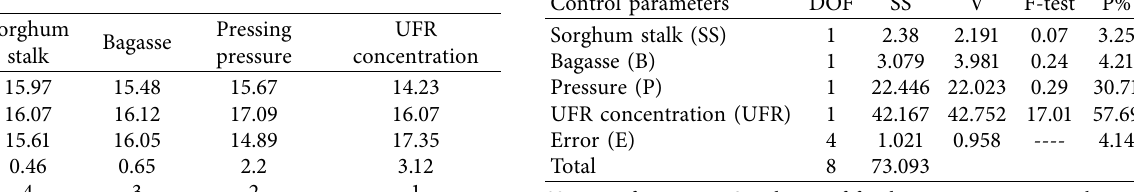
Figure 6: Main effect plot for the SN ratio for internal bonding strength. Table 6: Response for signal-to-noise ratios “larger is better” for Table 7: ANOVA results for flexural strength MOR.